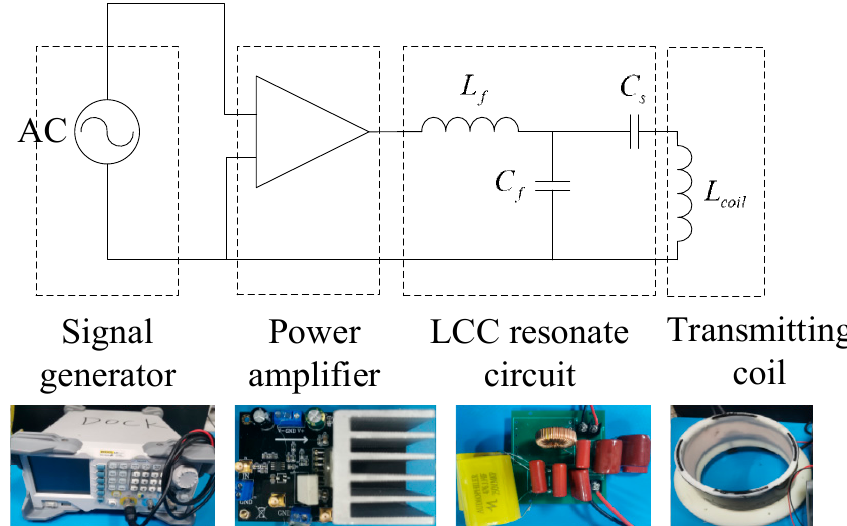
Figure 11. Schematic diagram of the coil drive circuit.